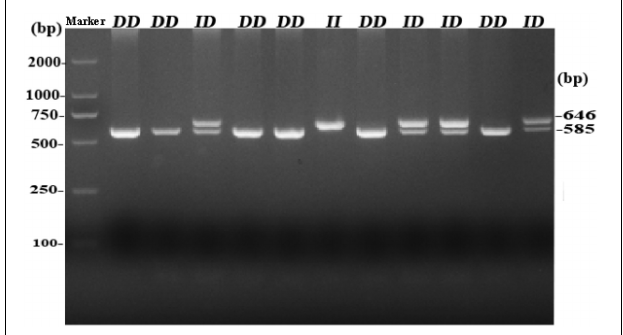
FIGURE 1 | Agarose gel electrophoresis pattern of the RIN2 61-bp indel polymorphism.